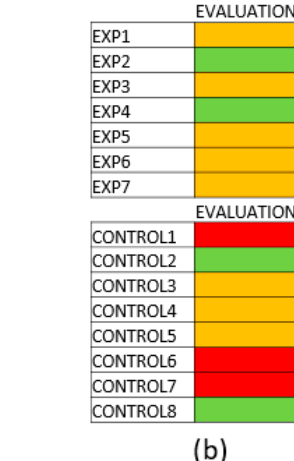
Figure 8. Alert levels referring to a team member’s low participation ( a ) during the last three sessions of experimental groups and ( b ) final evaluation of experimental and control groups. A contingency table with the total percentage of alarm frequencies is shown in Table 11. The proportion of the green level in the control and experimental groups is the same.